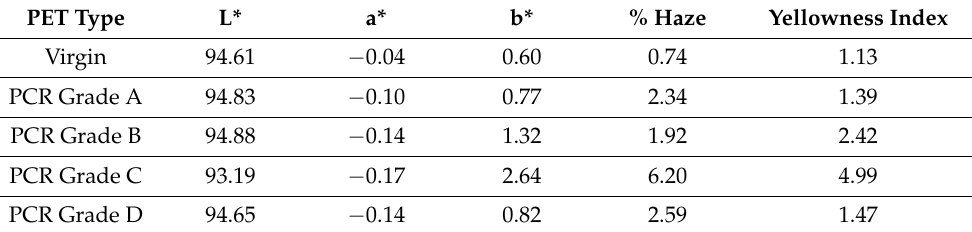
on Colorquest™ equipment. With the thin wall, the lightness dimension of color scale (L* value) of the container is barely different than the virgin container. The other two dimensions a* (green-red dimension) and b* (blue-yellow dimension) are relatively closer. The difference in % haze and in yellowness index is more significant. Table 1. Color and haze of different polyethylene terephthalate (PET) bottles made with different post-consumer recycled (PCR)